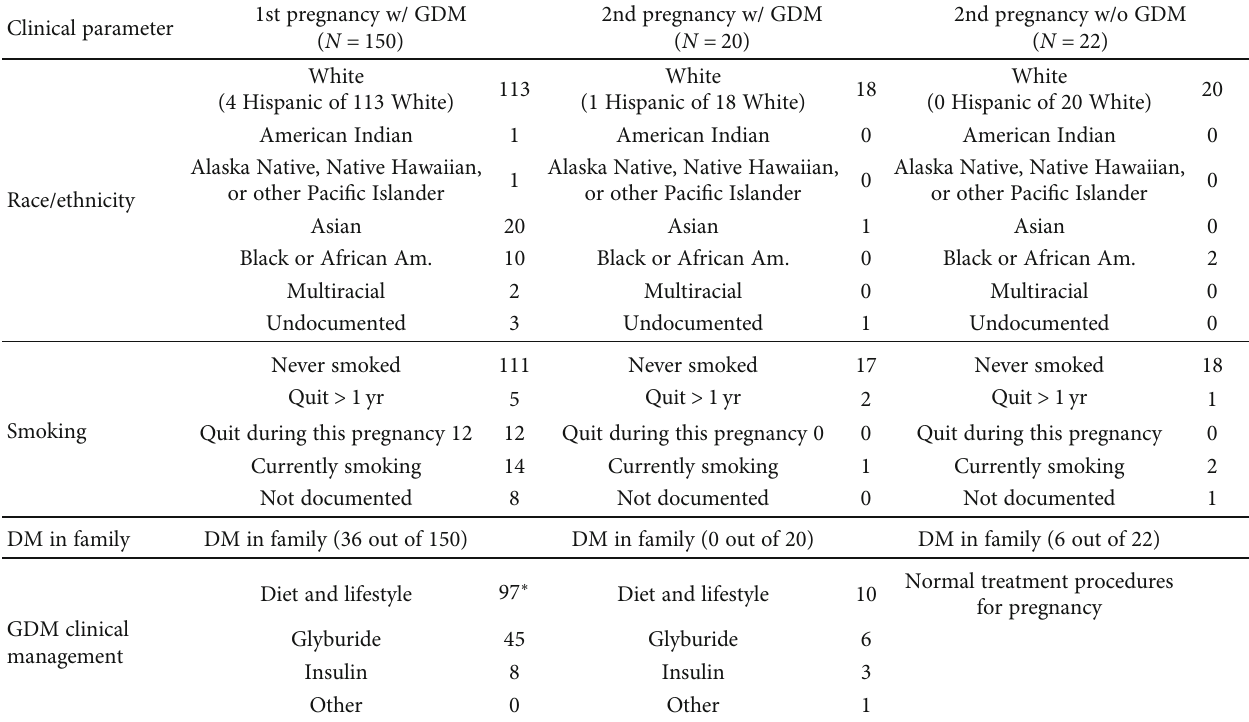
Table 2: Clinical parameters for data analysis